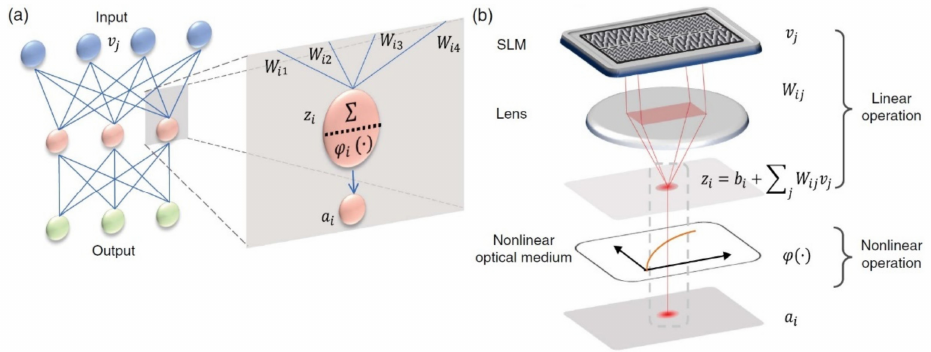
Figure 2. ( a ) A neural network with two layers and a detailed view of one of its neurons. ( b ) Imple- mentation of an optical neuron with linear operation (SLM and lens units) and non-linear operation (activation function ϕ )